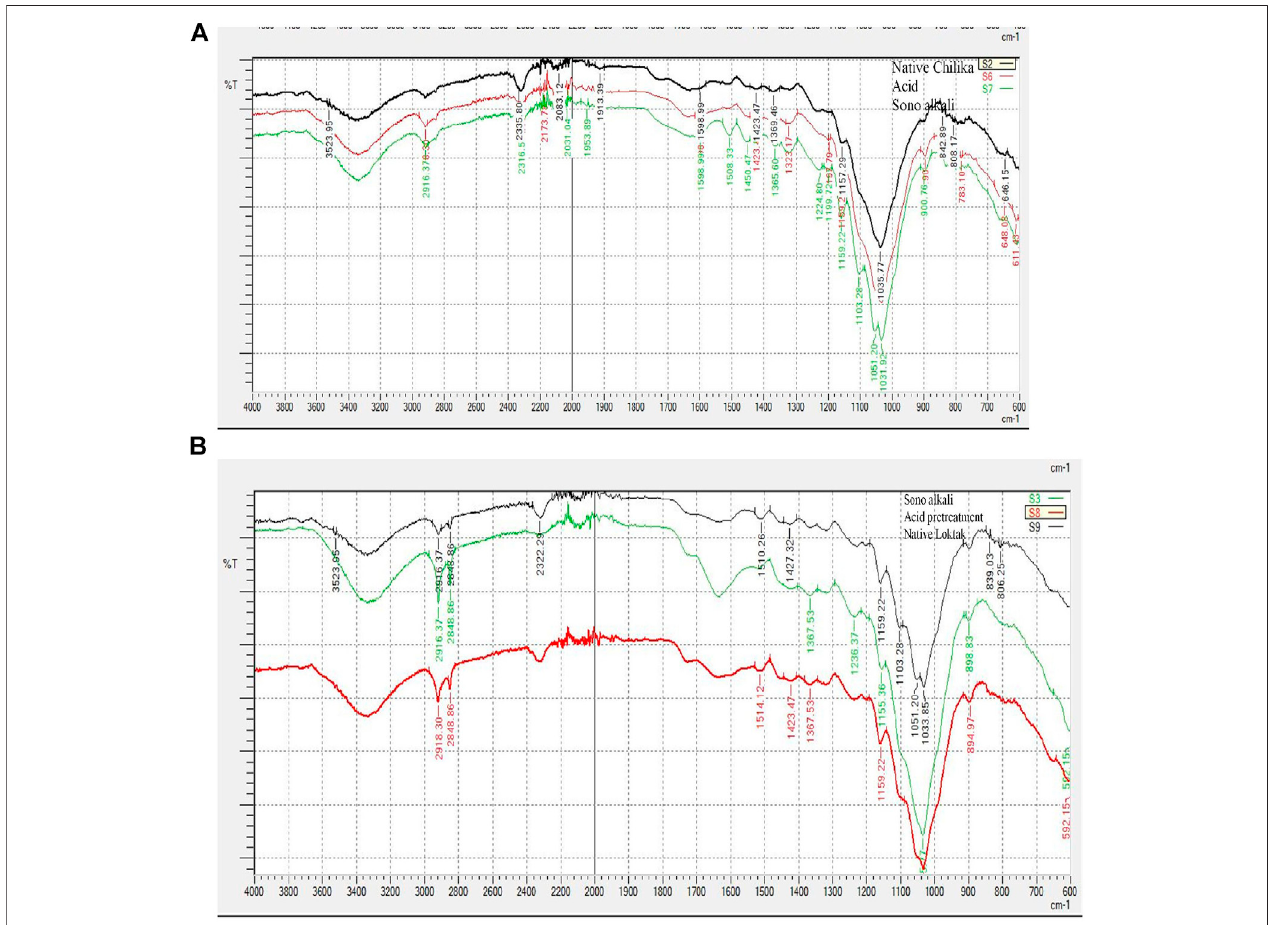
FIGURE 2 | FTIR spectra of native and pretreated samples of tall reed grass: (A) Chilika Lake and (B) Loktak Lake.